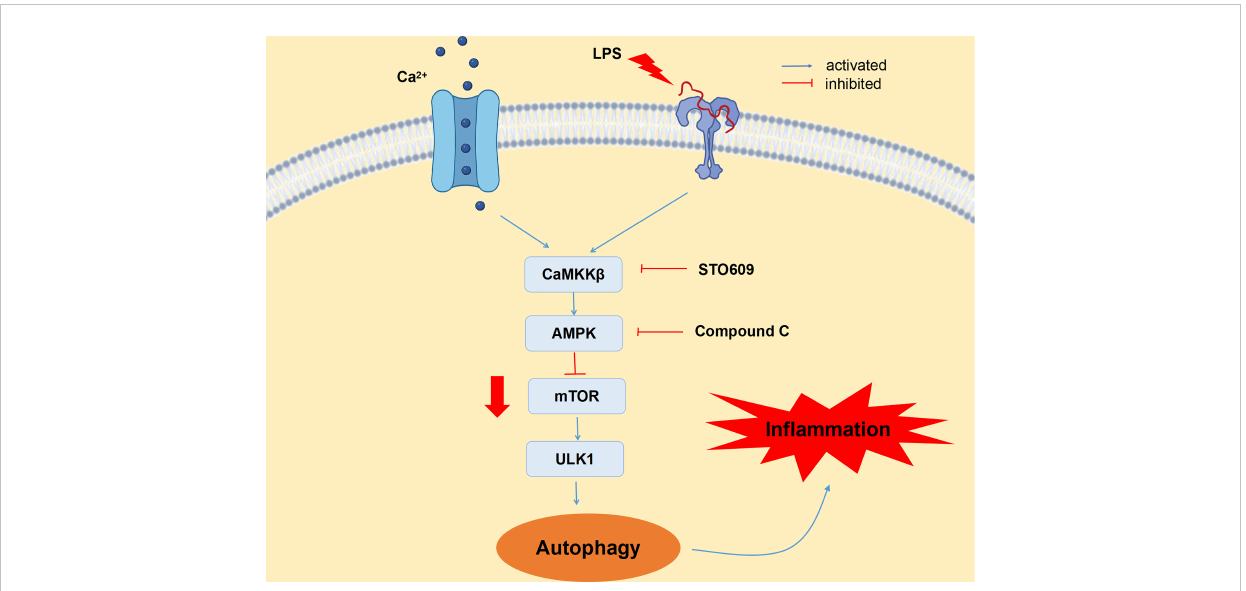
FIGURE 7 CaMKK b – AMPK signaling pathway is involved in LPS-induced autophagy in bovine mammary epithelial cells. LPS upregulated CaMKK b expression by increasing intracellular calcium ion content, thereby activating AMPK signaling pathway and thus inducing autophagy. LPS induces